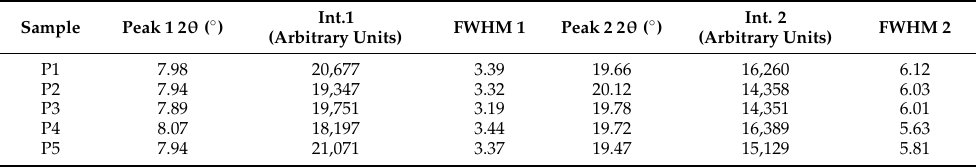
Table 3. The parameters calculated from XRD data of P1 – P5 co-polymer samples: peak position,